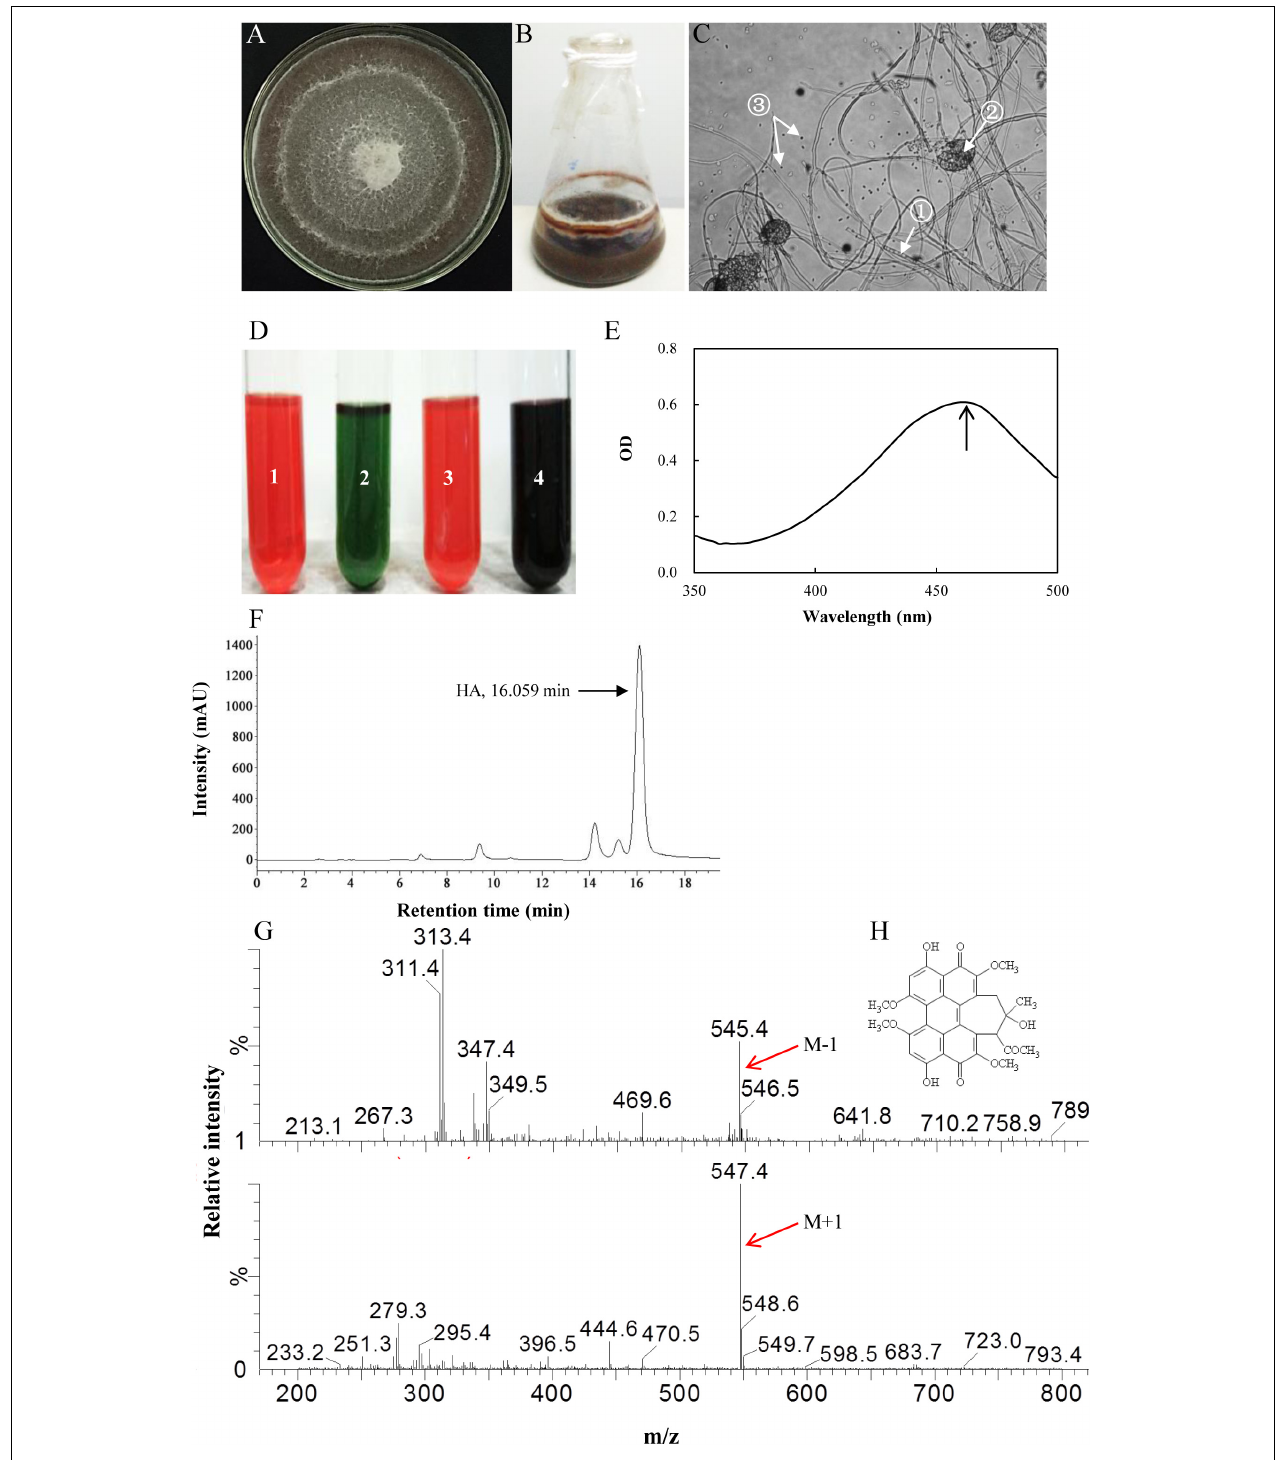
FIGURE 2 | Characterization of hypocrellin production by strain S9. (A) The observation of the red pigment secretion on day 10 of the strain on PDA. (B) The fermentation of the strain in PDB for 4 days. (C) The morphological structure of the strain under optical microscope (100 × ). (cid:172) Septal hypha; (cid:173) pycnidium; (cid:174) conidium. (D) The typical color reaction. Pigment acetone extract (1) with 1 mol/L sodium hydroxide solution (2). Pigment acetone extract with 1 mol/L hydrochloric acid solution (3). Pigment acetone extract with 1 mol/L FeCl 3 solution (4). (E) Full wavelength scanning of the strain acetone extracts. (F) The retention time of HA of wild Shiraia sp. S9 by HPLC. (G) Qualitative analysis of HA by LC–MS. M-1, m/z [M-H] 545.4, negative ion spectra with one adduct proton. M + 1, m/z [M + H] 547.4, positive ion spectra with one adduct proton. (H) The structure of HA. Molecular formula: C 30 H 26 O 10 .